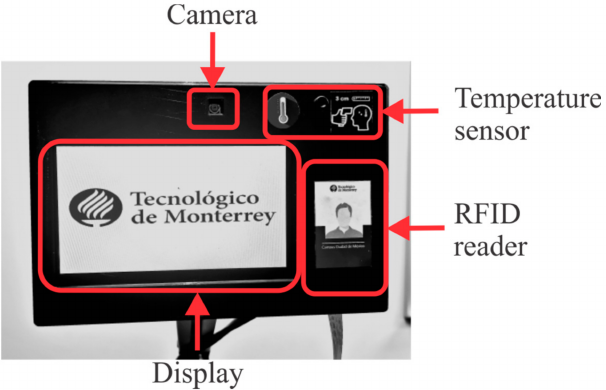
Figure 25. GUI for interaction and identification of users.